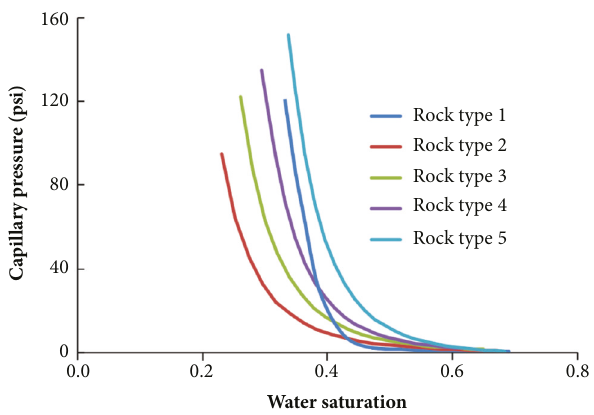
Figure 3: Capillary pressure curves of five rock types.